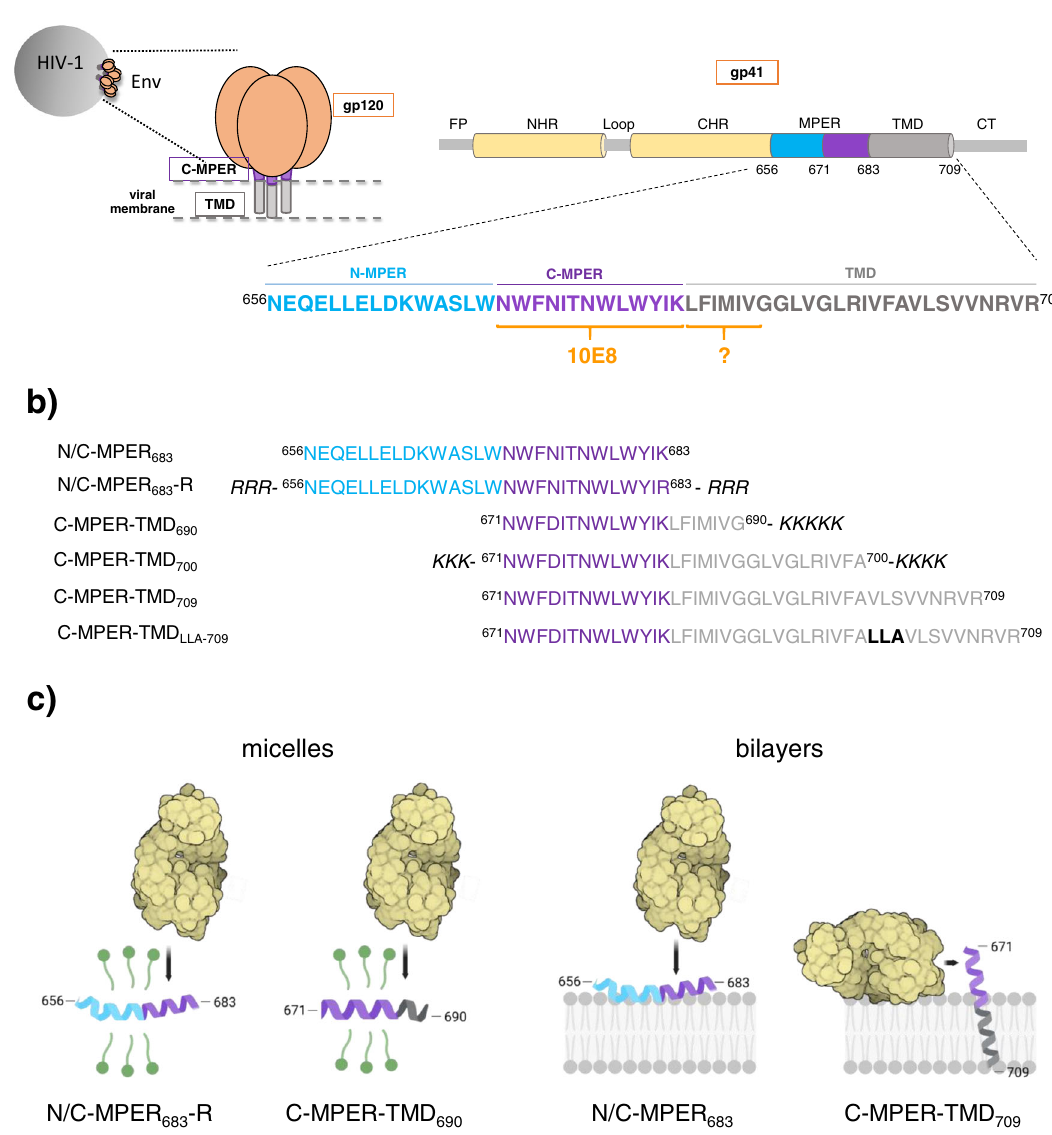
Fig. 1 Peptides and model systems selected to study 10E8 binding to the C-MPER helix in membrane mimetics. a Sequence and range of N-MPER, C-MPER and TMD domains within the HIV-1 Env subunit gp41. The orange line denotes the sequence spanning the nominal 10E8 epitope. The question mark raises the possible contribution of TMD residues. The diagram on top depicts the different domains of gp41: FP, fusion peptide; NHR and CHR, amino- and carboxy-terminal helical regions, respectively; MPER, membrane-proximal external region; TMD, transmembrane domain; CT, cytoplasmic domain. b Sequence and designation of the N/C-MPER and C-MPER-TMD-based peptides used in this study. c Models for recognition of the C-MPER helix by the Fab 10E8 in detergent micelles or inserted into phospholipid bilayers. The latter are depicted as interfacial or membrane-spanning helices. (Created with